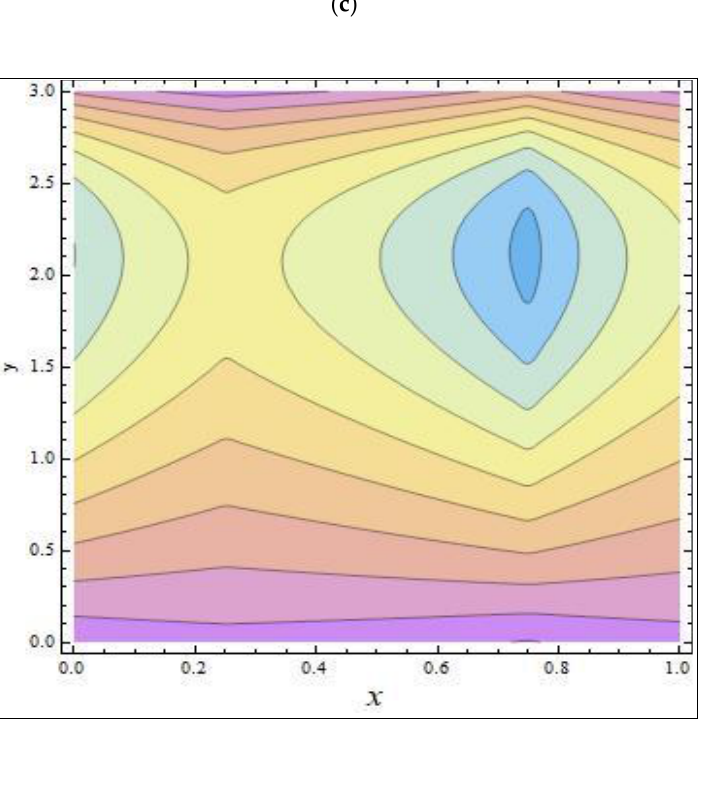
Figure 10. The streamlines of different wave shapes: ( a ) sinusoidal wave; ( b ) multi-sinusoidal wave; ( c ) trapezoidal wave; ( d ) triangular wave. The values of the other parameters were N CT = 0.3, N TC = 0.7, G rc = 0.4, G rF = 0.1, G rt = 0.5, N t = 0.7, M = 3.5, φ = π m = 0.6, Q =